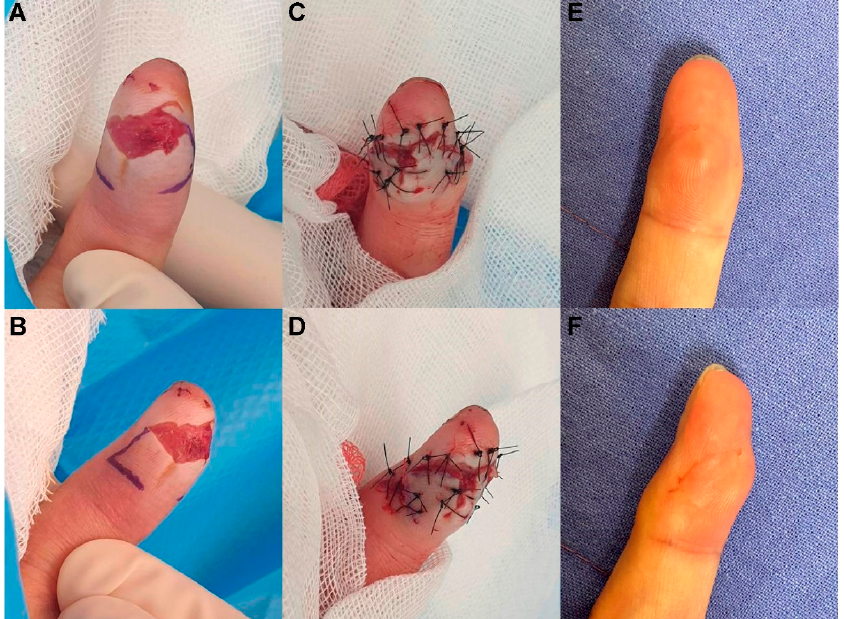
Figure 4. Clinical photographs of a 36-year-old man who sustained a left fifth fingertip injury caused by a cutter knife. ( A , B ) A tiny volar pulp defect of the right second fingertip (0.6 cm × 1.5 cm), and design of a modified mini-keystone flap (m-KF) (0.8 × 2.5 cm). ( C , D ) Successful coverage of the defect with the modified m-KF. ( E , F ) Postoperative photographs obtained at the 6-month follow-up.